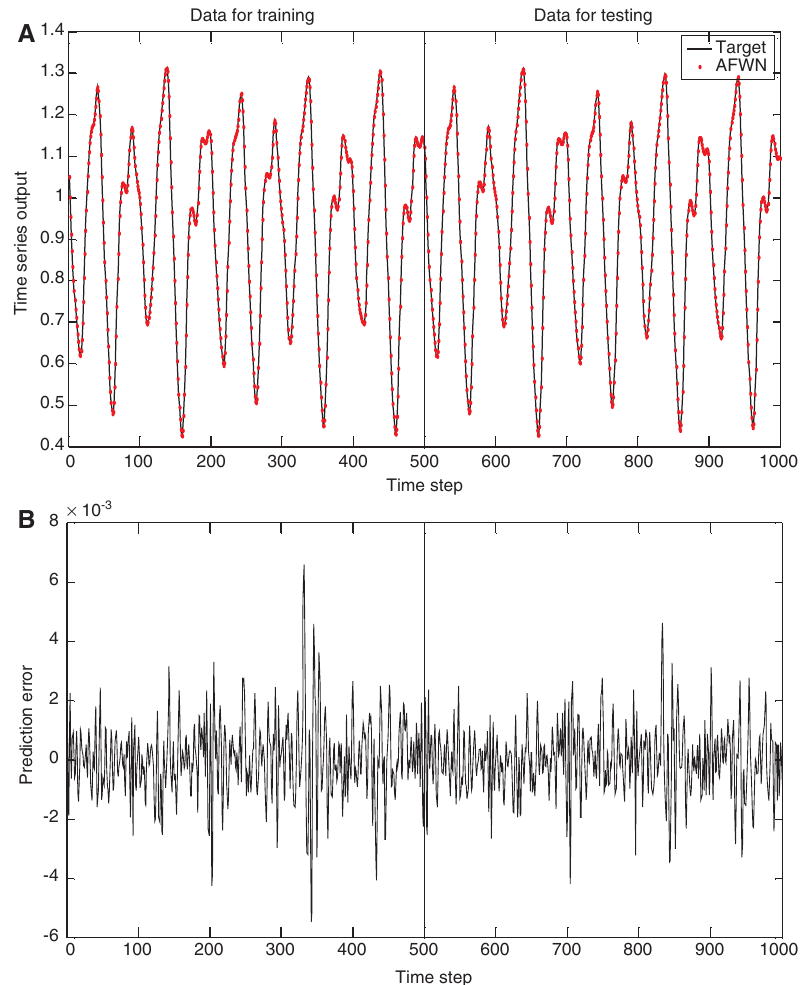
Figure 4. AFWNN Model Results for Mackey Glass Time Series. (A) Actual and prediction values. (B) Prediction